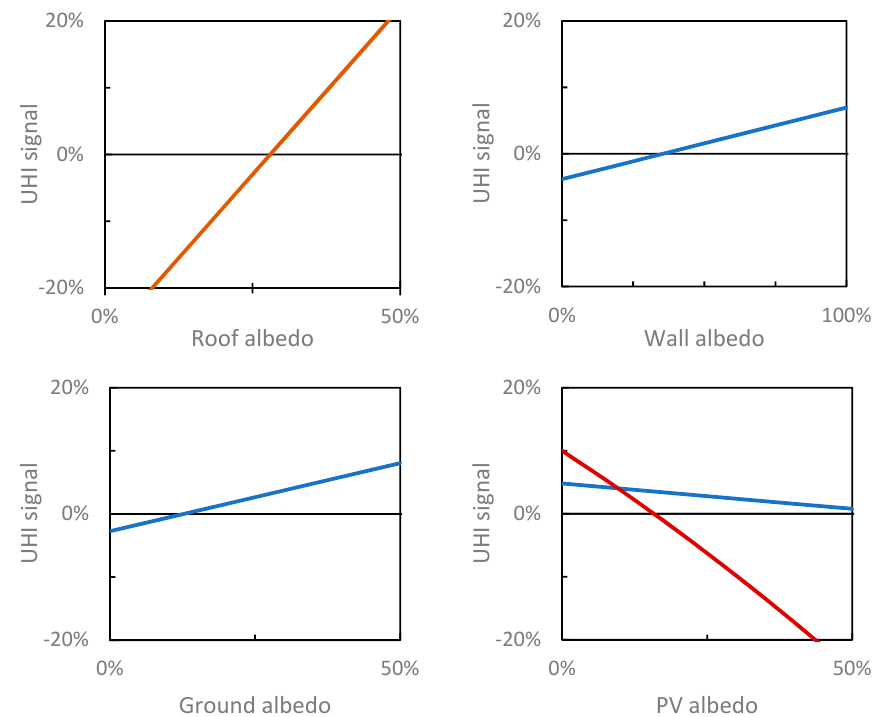
Figure 6. Sensitivity analysis for the relative irradiance balance, the UHI signal, for rooftops (red line) and facades (blue line) to the rooftop albedo (left), wall albedo (center) and ground albedo (right). Reference case: η = 20%; α PV = 10%; α r = 30%; α w = 70%; α g = 30% .